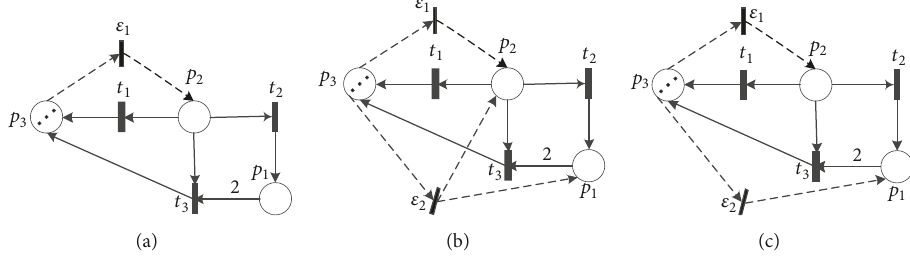
Figure 3: (a) A net satisfying 𝑡 1 𝑡 2 ∈ Ω(𝑃𝑁,𝑀 0 ) , (b) a net after 𝜀 2 is added, and (c) a net with a simpler structure than (b).